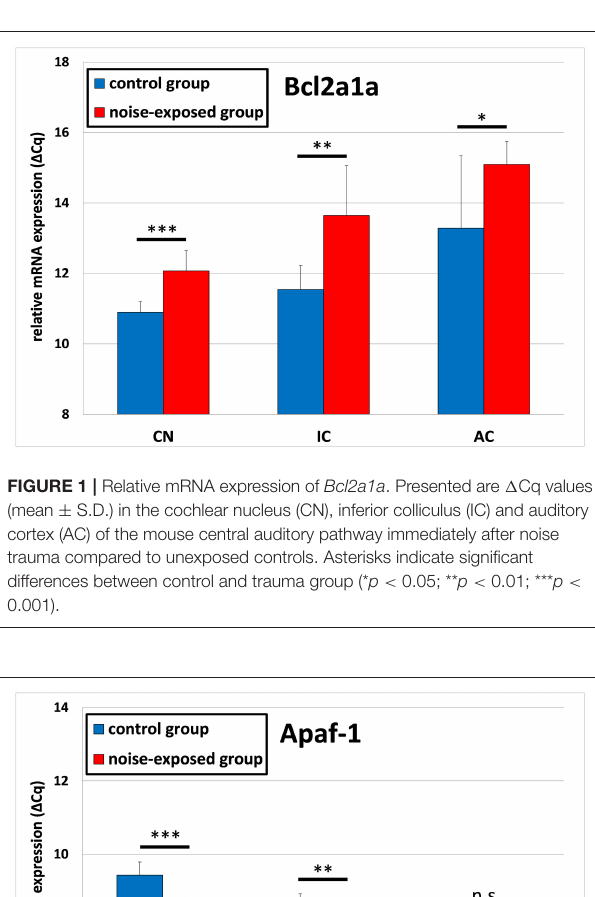
[control group: 7.896 ± 0.211, trauma group: 7.860 ± 0.238; p = 0.752; t -test ( t = 0.322; df = 14)].